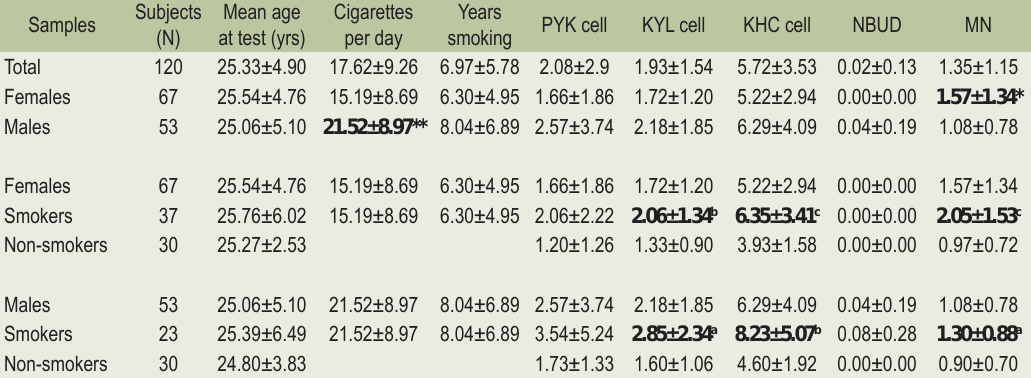
TABLE 2. Effects of sex and smoking on buccal cell MN and nuclear alteration frequencies in healthy persons (mean ± SD per